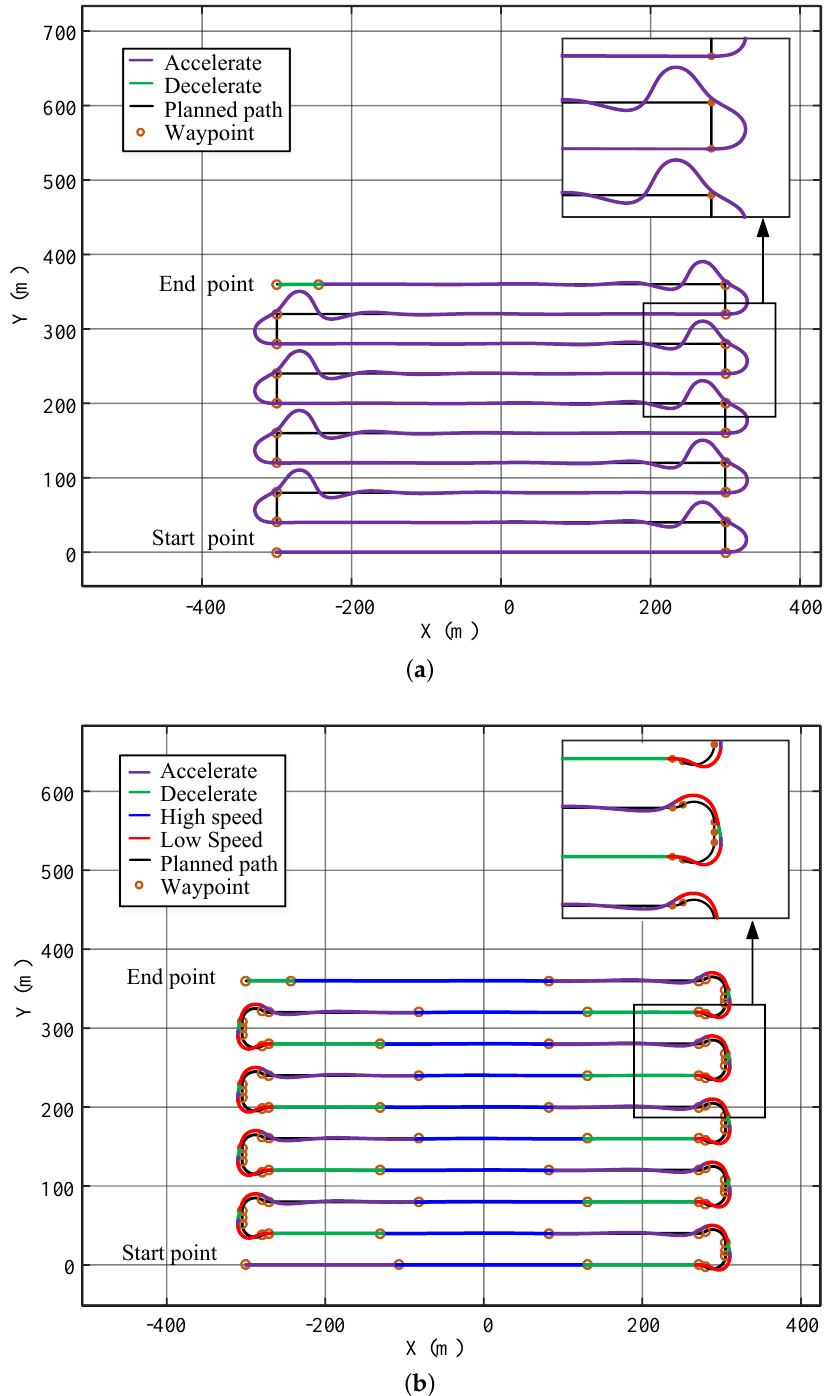
Figure 18. Simulation of bathymetric measurement: ( a ) Original path-tracing results. ( b ) Optimized path-tracing